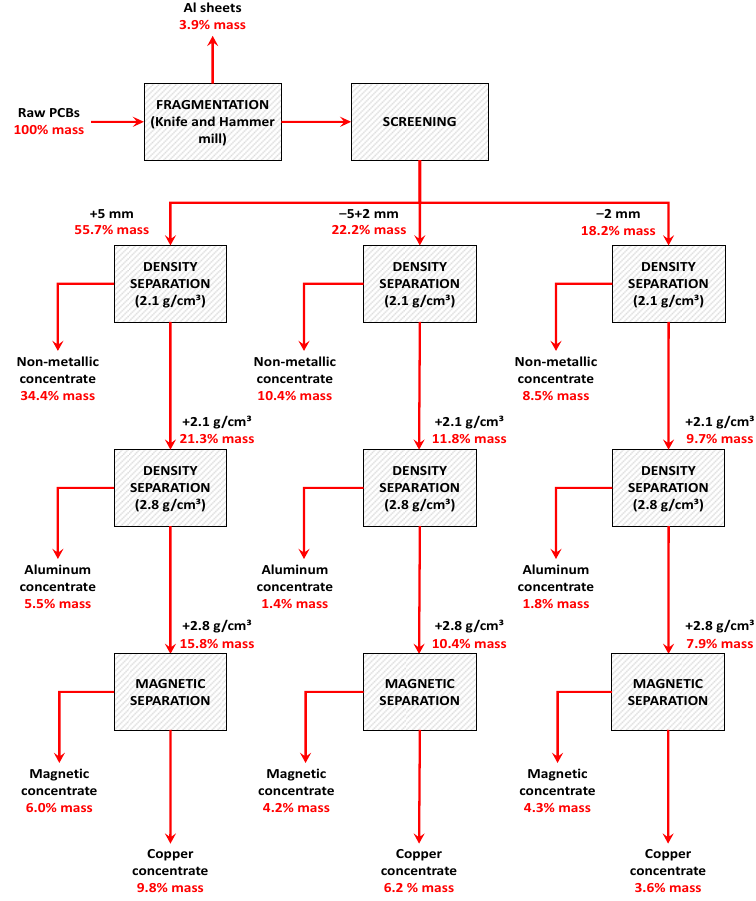
Figure 12. Proposed processing route of old PCBs and the global material balance.